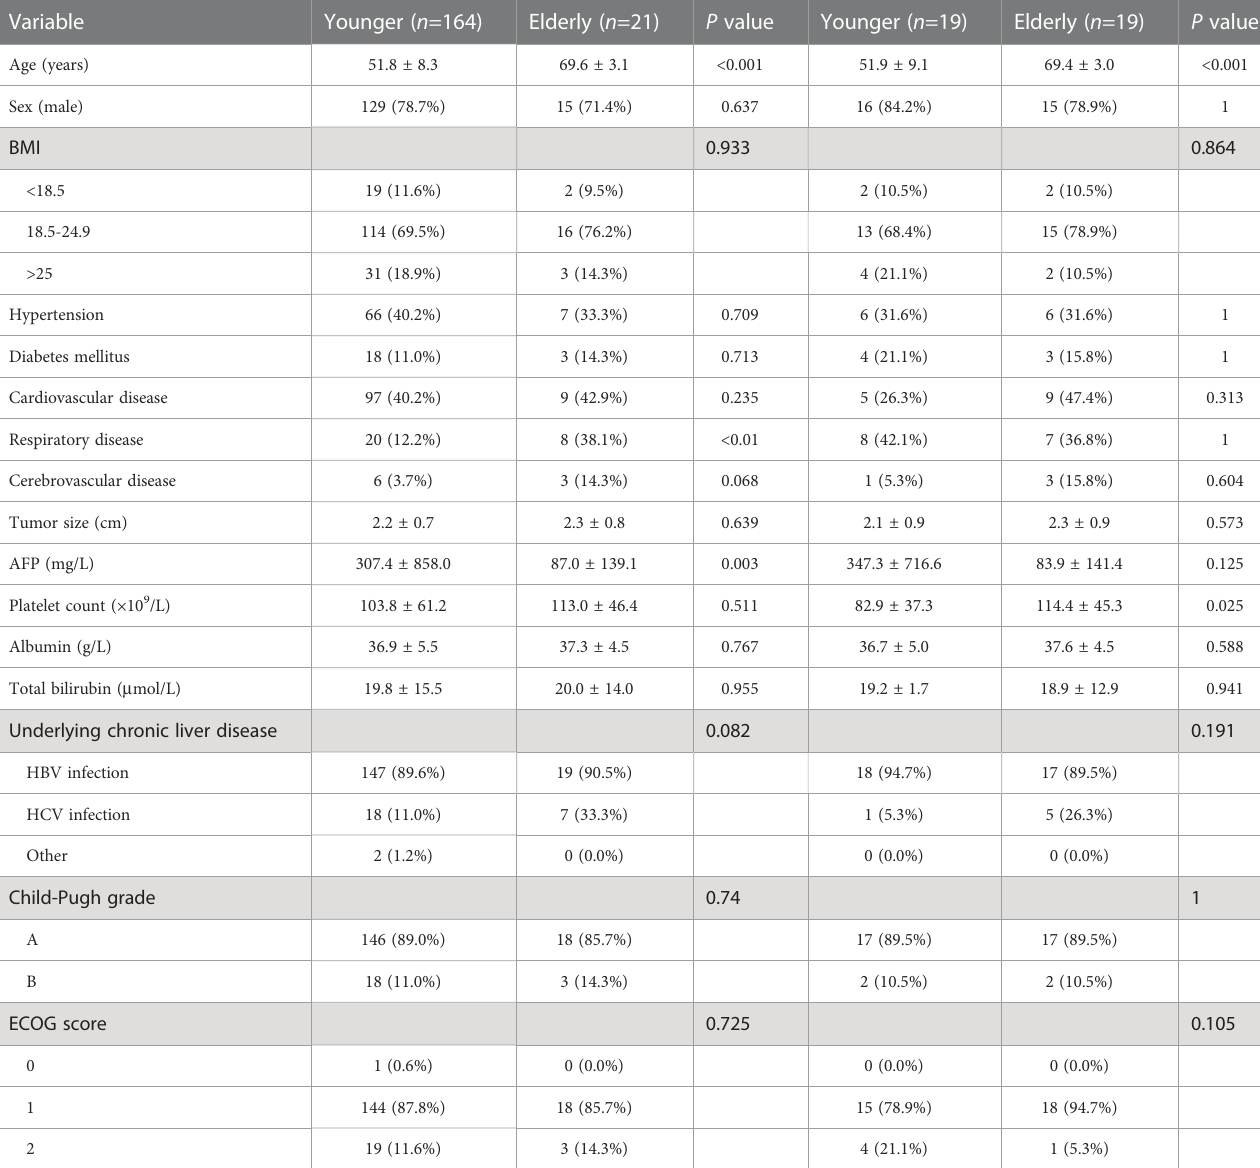
TABLE 3 Baseline characteristics of Group younger ( ≤ 65 years) and Group elderly (>65 years) before and after